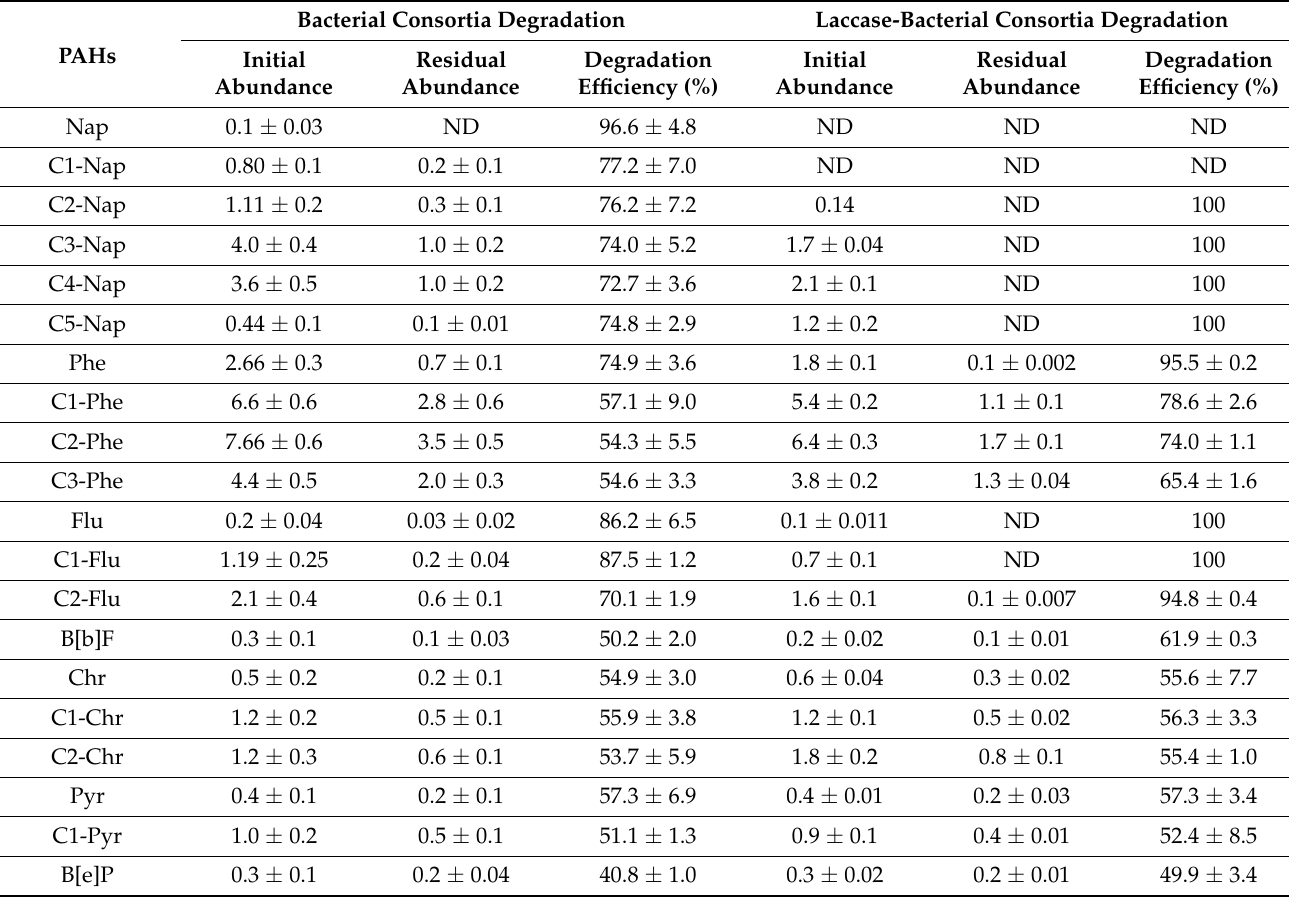
Table 2. Degradation efficiencies of the bacterial consortia and laccase-bacterial consortia for PAHs. Bacterial Consortia Degradation Laccase-Bacterial Consortia PAHs